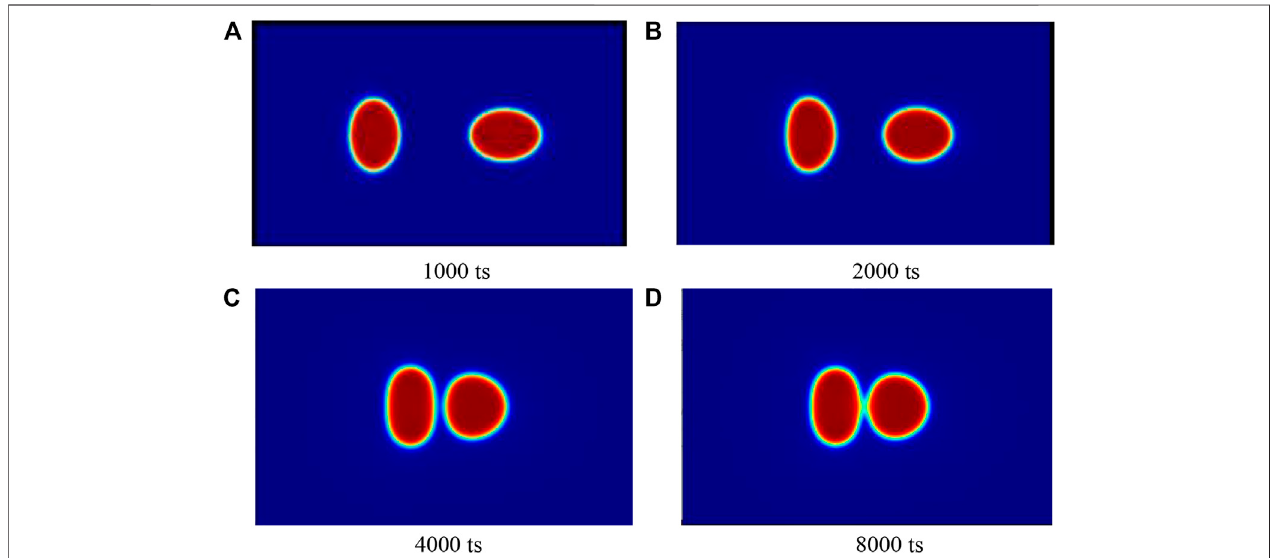
FIGURE2| Temporalsnapshotsoftwomovingdropletswithinthetimewindowfromstarttimepointtocontacttimepoint: σ (cid:1) 1 . 0 × 10 − 4 ,surfacethickness d (cid:1) 25 lattice units, viscosity ratio, and density ratio are set to be 10.